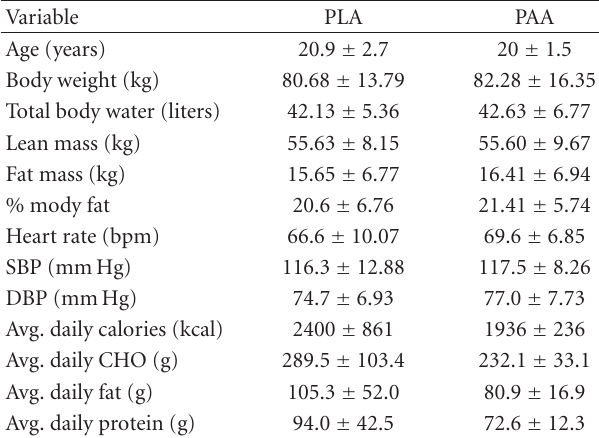
Table 1: Baseline participant demographic data for placebo (PLA) and protein/amino acid (PAA) groups. All data are presented as mean ± standard deviation. Results indicated no significant di ff erences between groups at baseline or throughout the course of the study ( P > 0 .